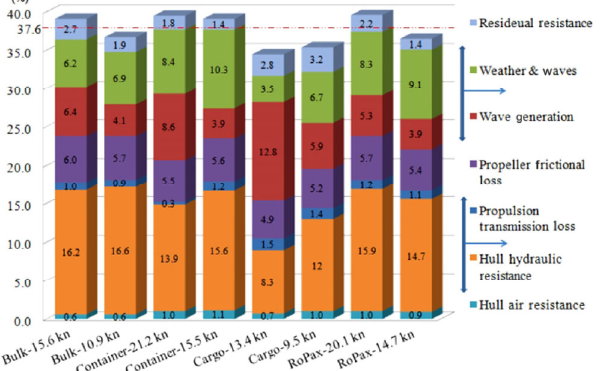
Fig. 1 Distribution of energy losses (%) involving tribology problems in selected case ships.